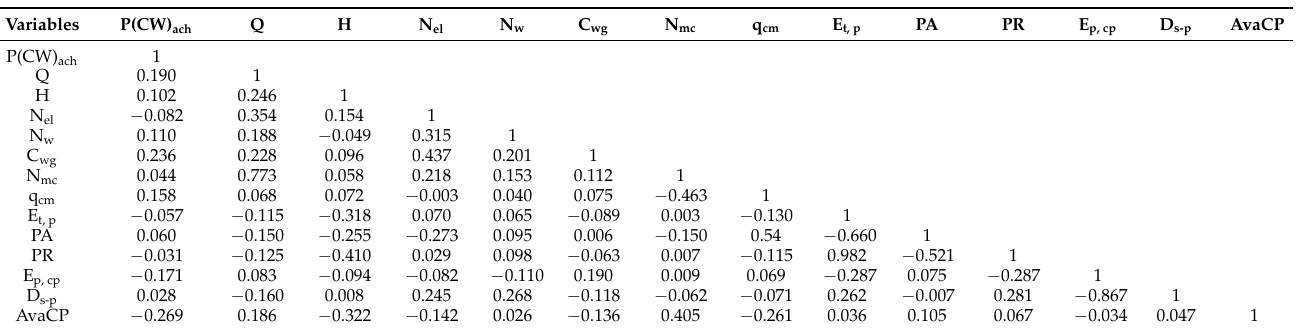
Table 1. Correlation matrix between all variables.